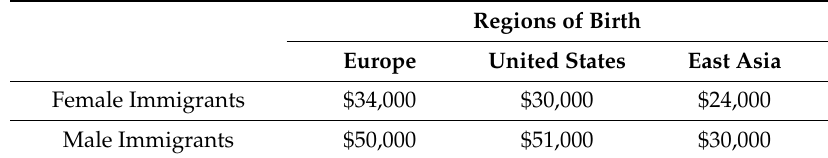
Table 6. Regions of Birth and Median Wages for Immigrants in 2015 who landed in 2005 (Statistics Canada